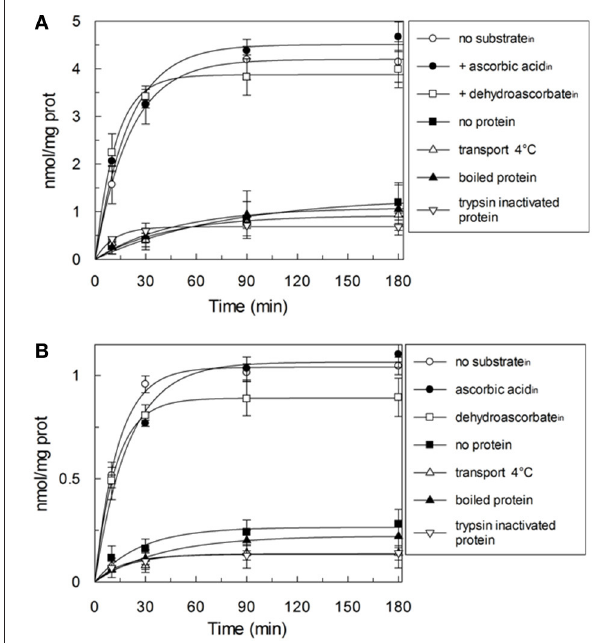
FIGURE 2 | Time-course of the ascorbic acid uptake in reconstituted proteoliposomes. The uptake was started by adding 0.1mM external [ 14 C]ascorbic acid at time zero to proteoliposomes reconstituted with HTP eluate from rat liver (A) or potato (B) . Proteoliposomes were reconstituted ◦ • without ( , (cid:4) , 1 , N , ∇ ) or with 10mM ascorbic acid ( ) or 10mM DHA ( (cid:3) ) as internal substrate. Transport was stopped by adding 15mM PLP after the indicated time intervals. Data are means ± SD from three independent experiments.